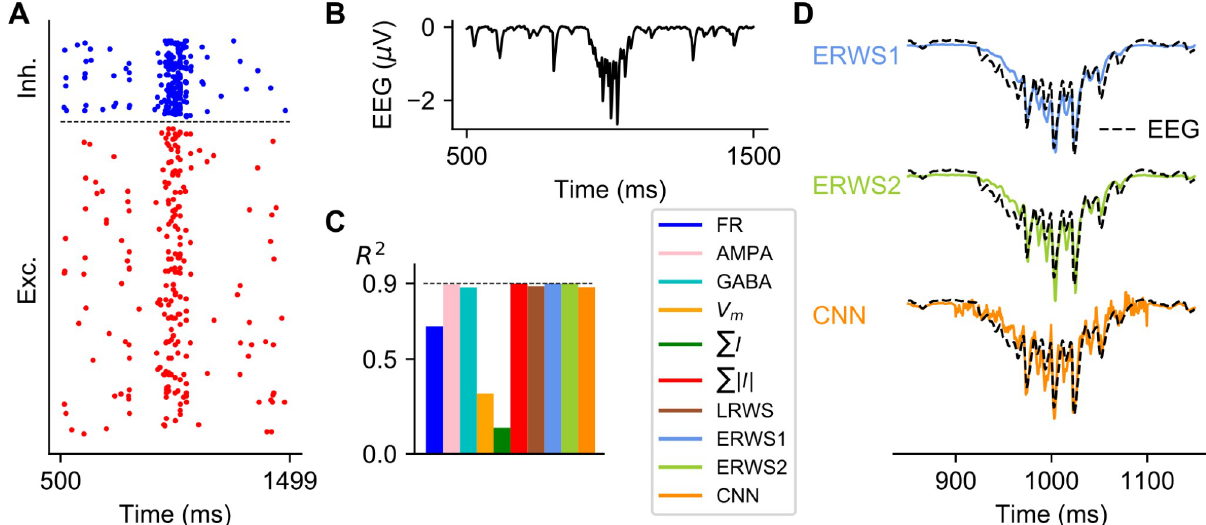
Fig 10. Effect of transient activation of thalamic input with a Gaussian pulse packet. (A) Raster plot of spiking activity from a subset of cells in each population in response to a transient spike volley with a Gaussian rate profile ( σ = 30 ms) centered at 1000 ms. (B) Ground-truth EEG at the top of the head model. (C) Performance of proxies calculated between 850 and 1150 ms. (D) Outputs of ERWS1 , ERWS2 and the CNN compared to the ground- truth EEG.